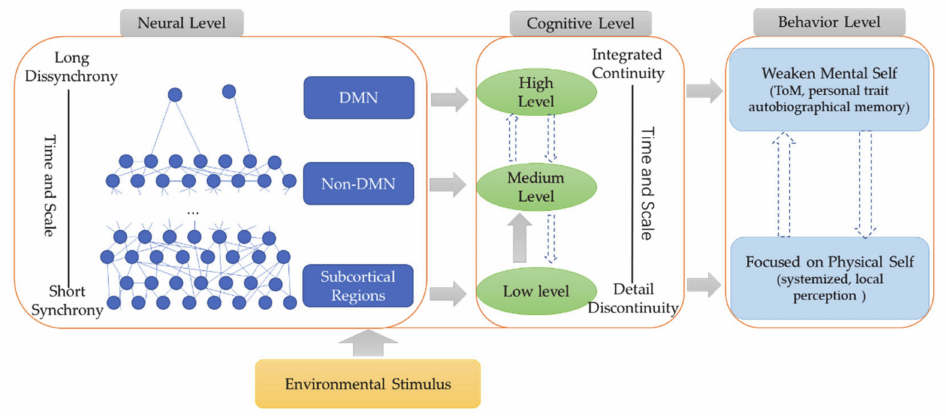
Figure 8. The altered hierarchy of the autistic self on neural, cognitive, and behavioral levels in ASD. Table 3. Summary of the relationship between the Hierarchical Model of Autistic Self (HAS) and other theories. HAS PC WCC TOMM DMN INTs